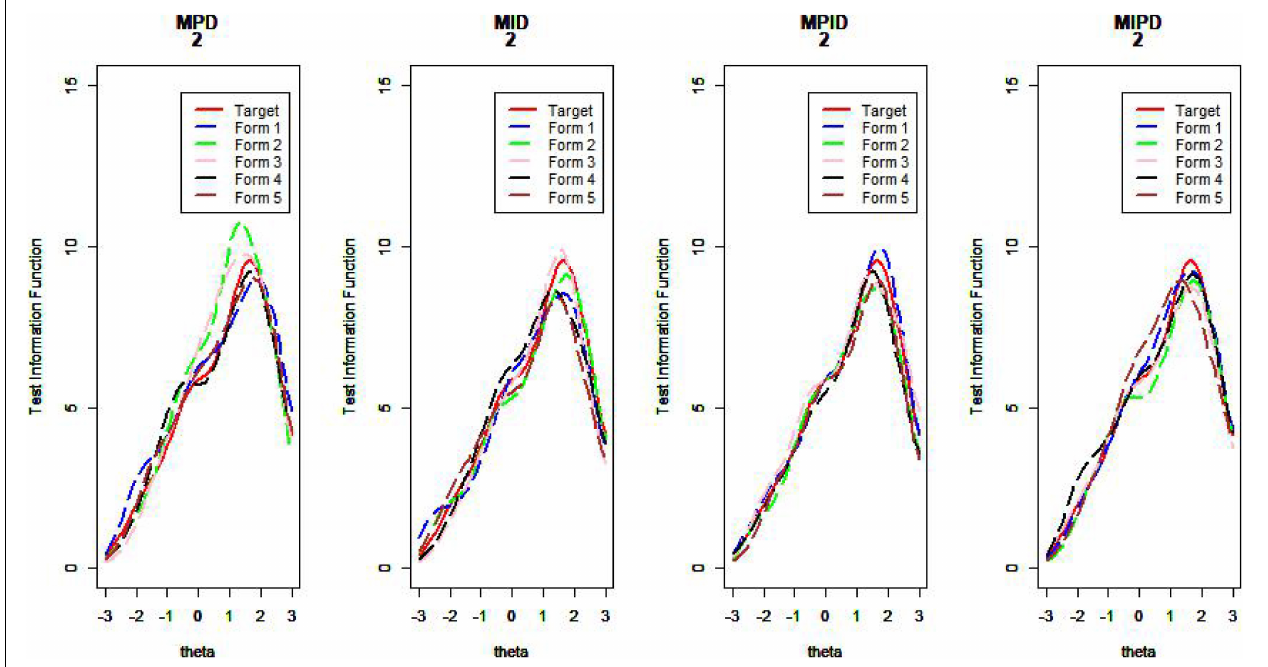
FIGURE 12 | Test information curve ( D = 2).